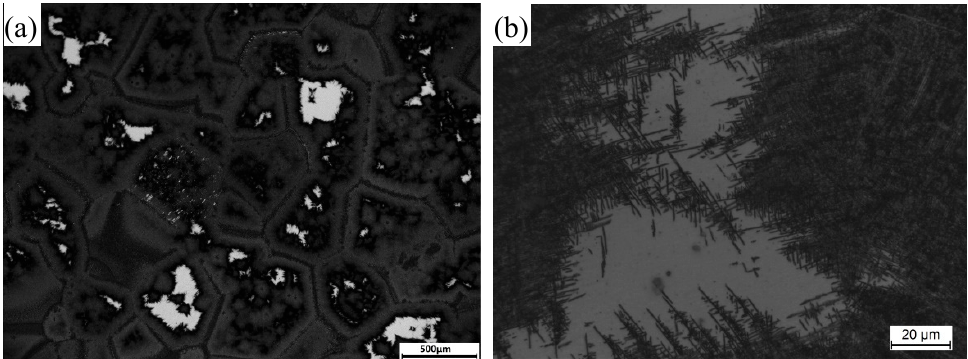
Figure 1. The large size PFZs after β annealing ( a ); a close inspection of PFZ ( b ).